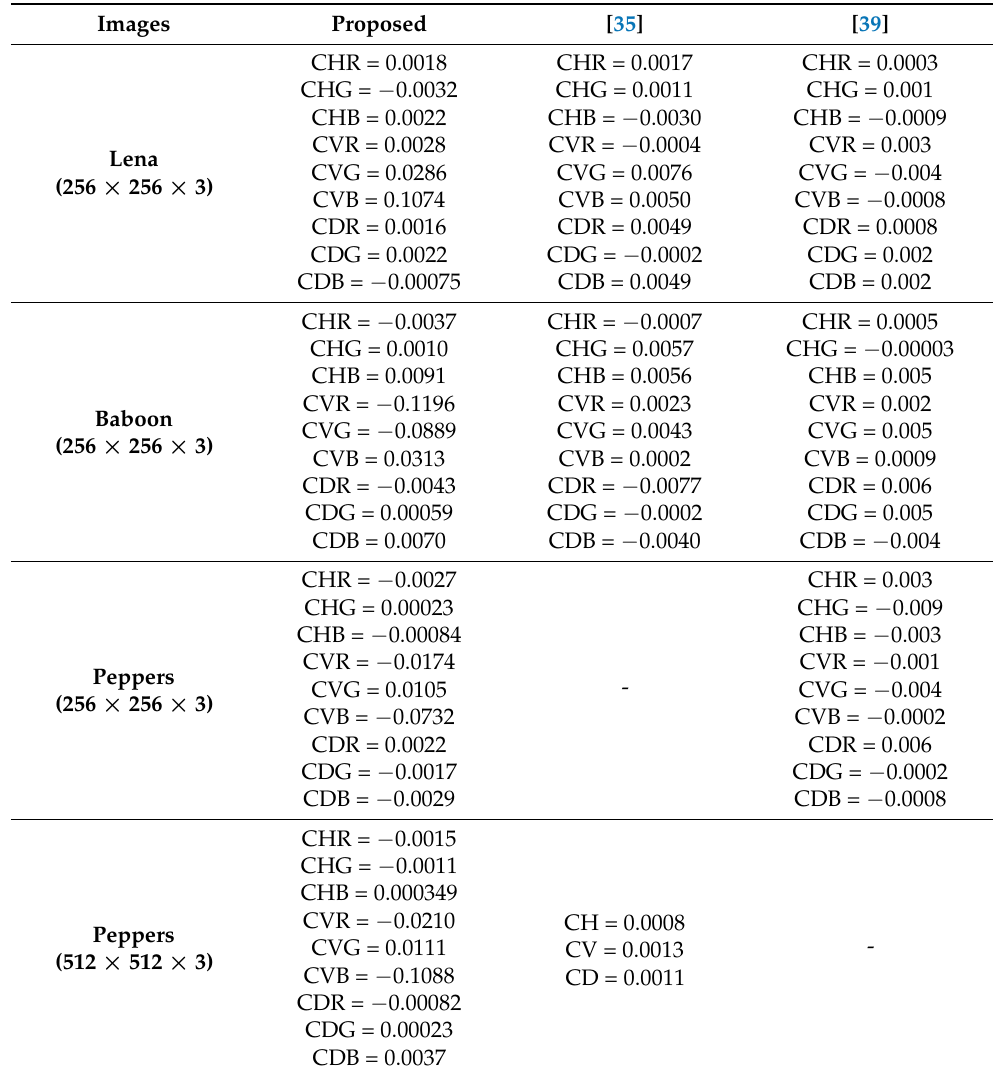
Table 6. Correlation coefficient